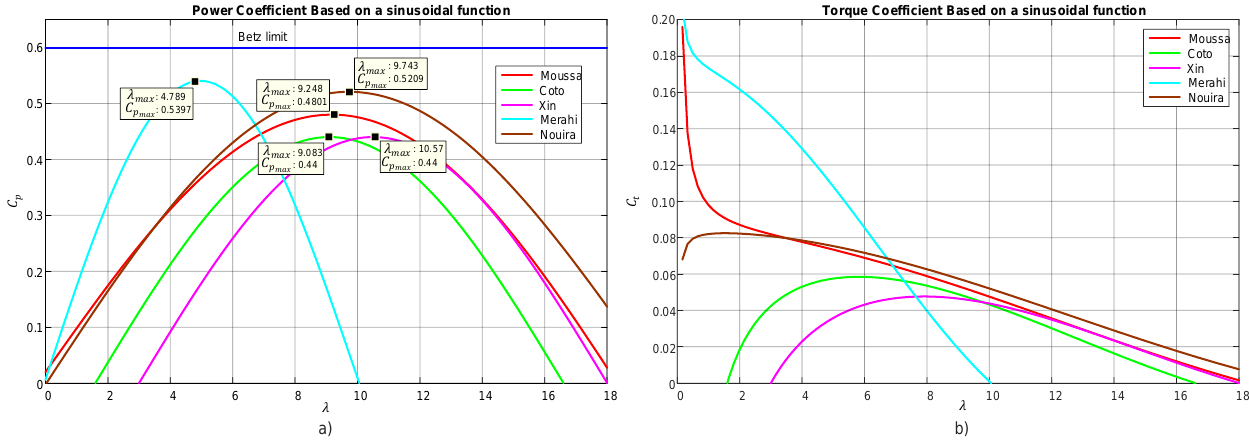
Figure 6. Coefficient based on a sinusoidal function; ( a ) power coefficient, ( b ) torque coefficient. Moussa [19], Coto [27], Xin [28], Merahi [29] and Nouira [18].